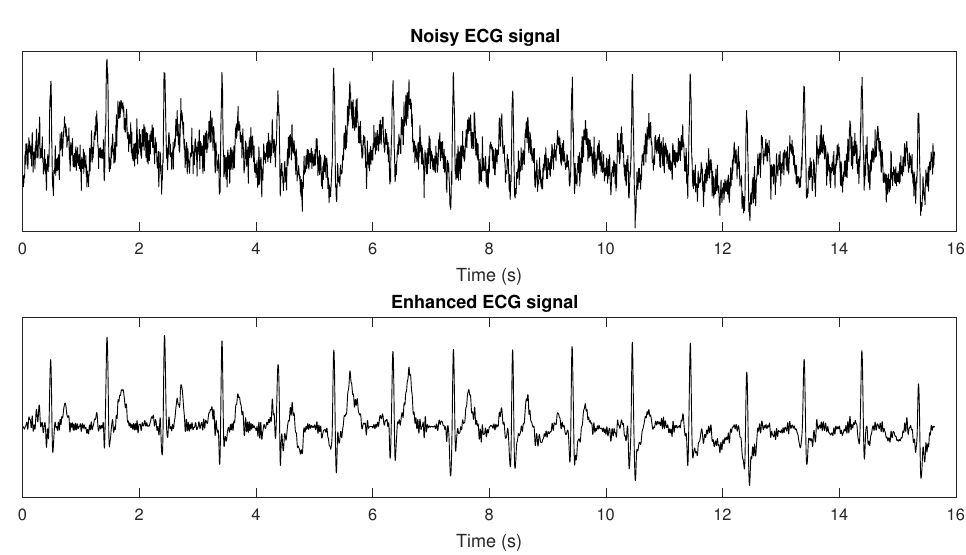
Figure 5. Plots of time domain ( top ) noisy ECG signal (60 bpm) corrupted with an SNR = − 5 dB and ( bottom ) its enhanced counterpart obtained after modulation spectrum domain based